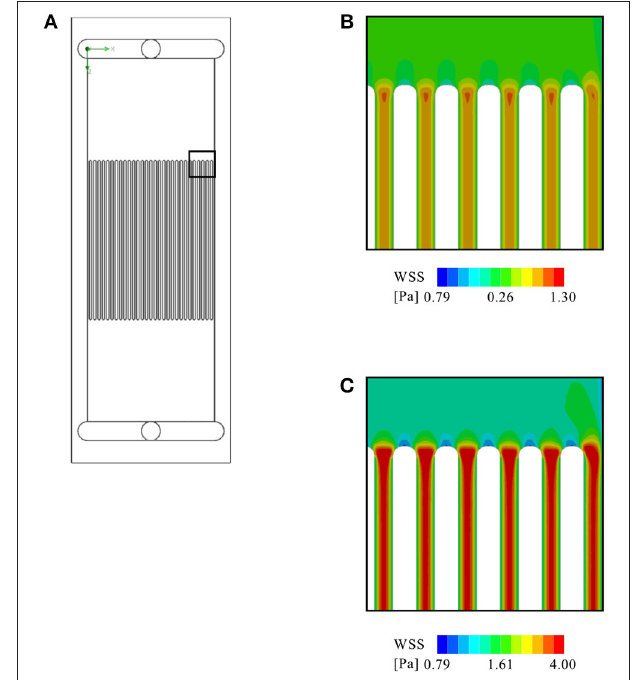
FIGURE 11 | CFD analysis of a virtual microfluidic insert consisting of 30 evenly spaced channels (each with a cross-sectional area of 0.3 × 0.3 mm 2 ): (A) The arrangement of the virtual microfluidic channels. Further shown are a close up of the contour plot of WSS on the glass slide at (B) 5 ml/min flow rate, and (C) at 20